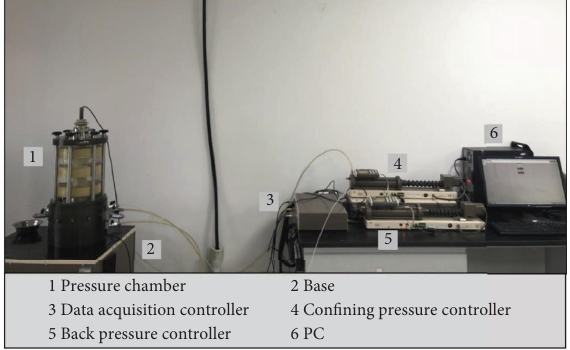
Figure 2: GDS dynamic triaxial apparatus.